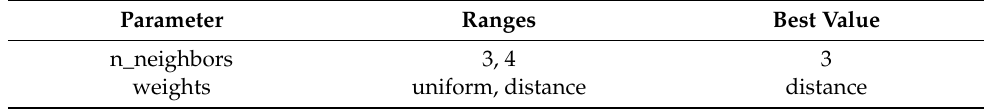
Table 4. Tuned parameters for KNN and KNN-WD.